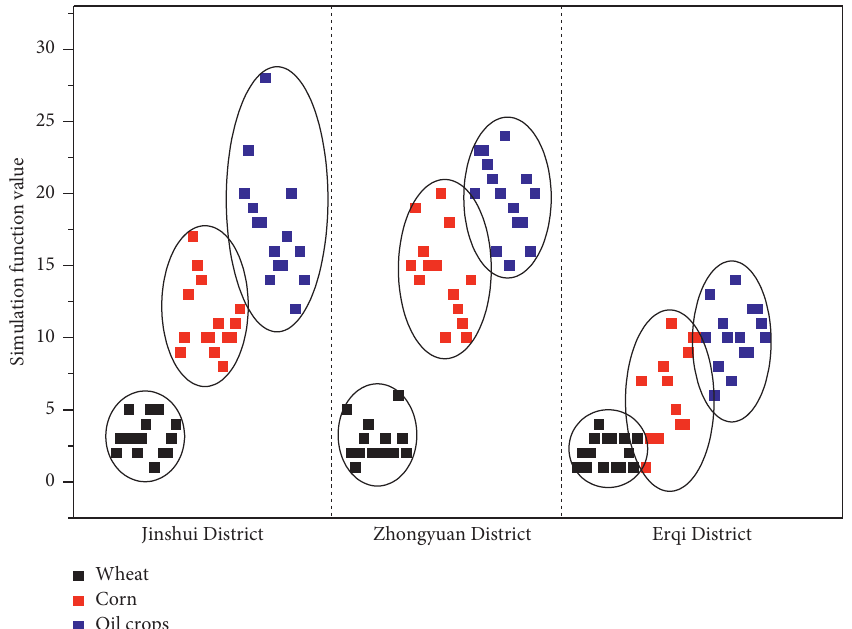
Figure 7: Relationship between simulation function values and different crops in three urban